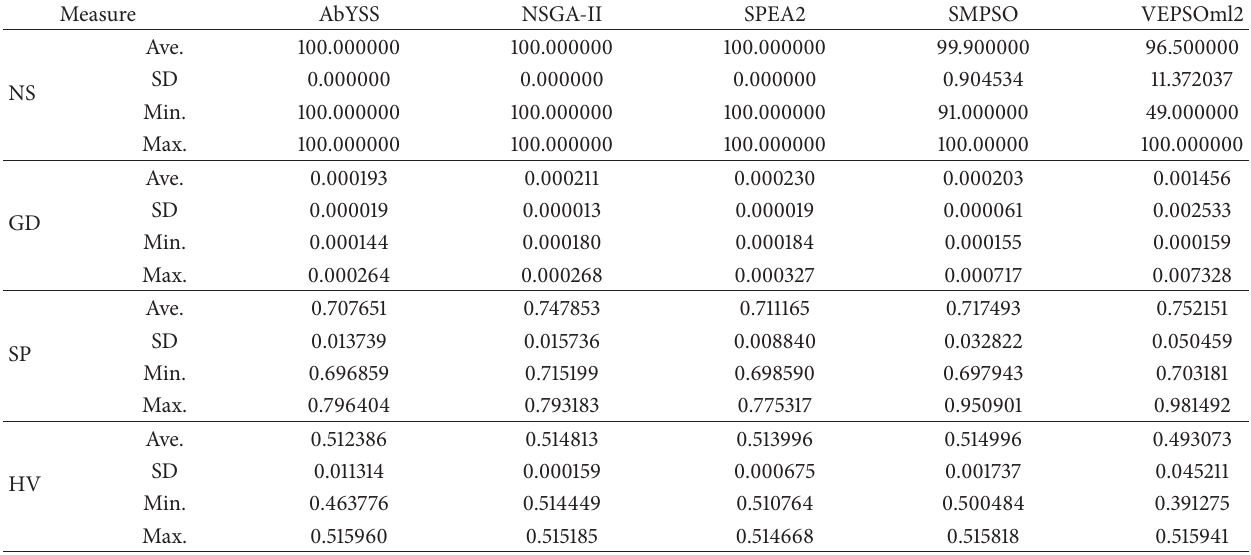
Table 9: Performance comparison based on ZDT3 test problem.